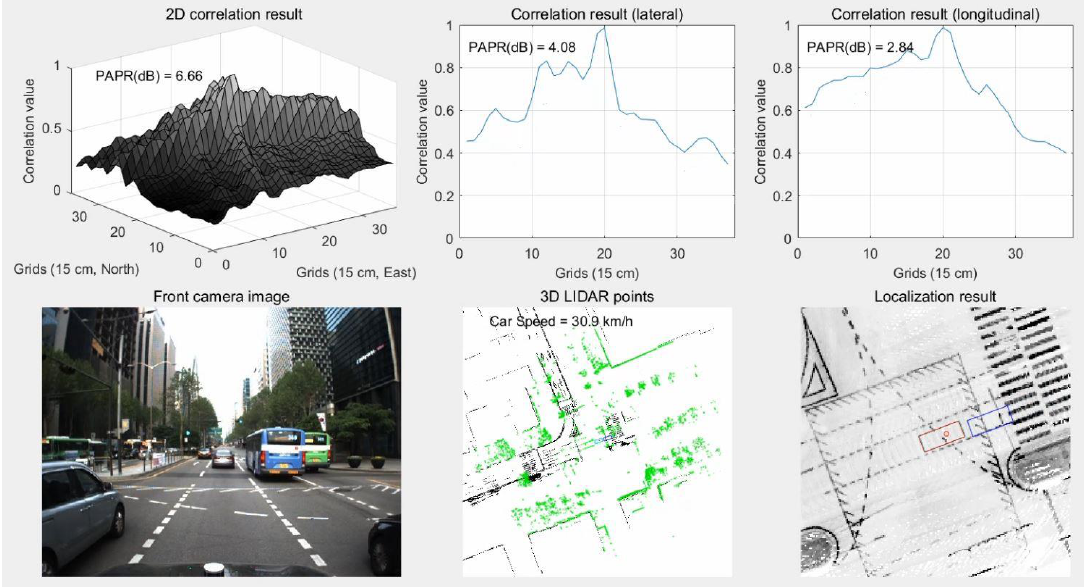
Figure 22. Localization execution process.